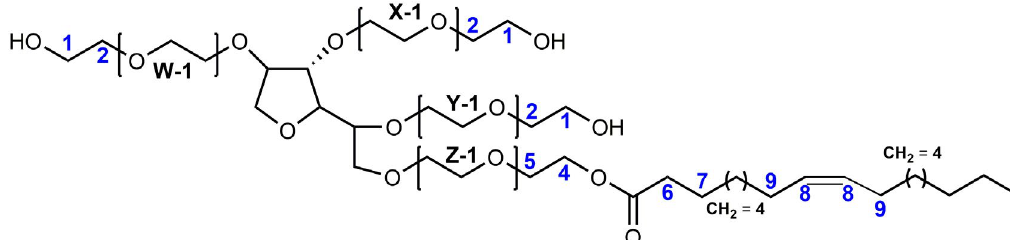
Fig 1. Chemical structure of PS 80, X + Y + Z + W = 20.